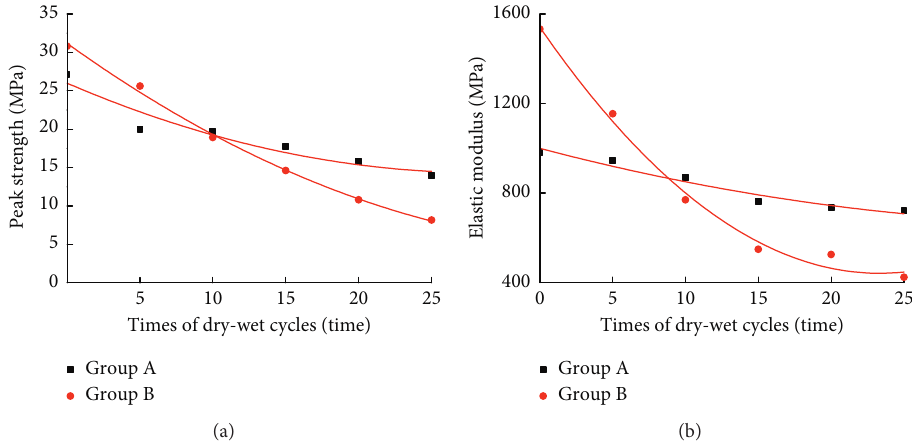
Figure 8: Mechanical strength of the feldspar sandstones after the dry-wet cycles. (a) Peak strength. (b) Elastic